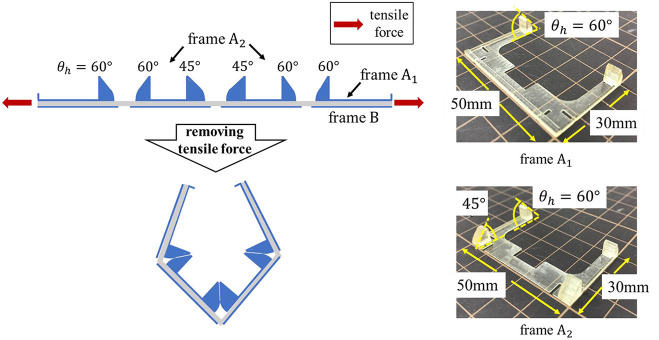
Blueprint of the gripper and appearance of frames A1 and A2.